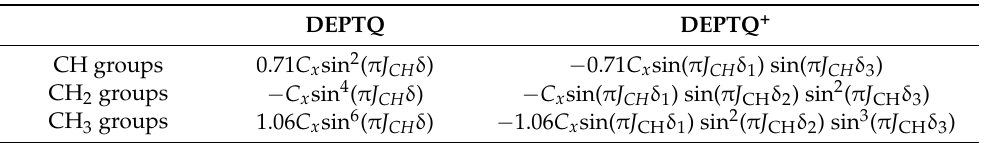
Table 1. Final carbon signal intensities, represented by I , for the three groups CH, CH 2 , and CH 3 for Ω = 90 ◦ , θ = 135 ◦ , as a function of the coupling constant J CH and the delays δ , δ 1 , δ 2 , and δ 3